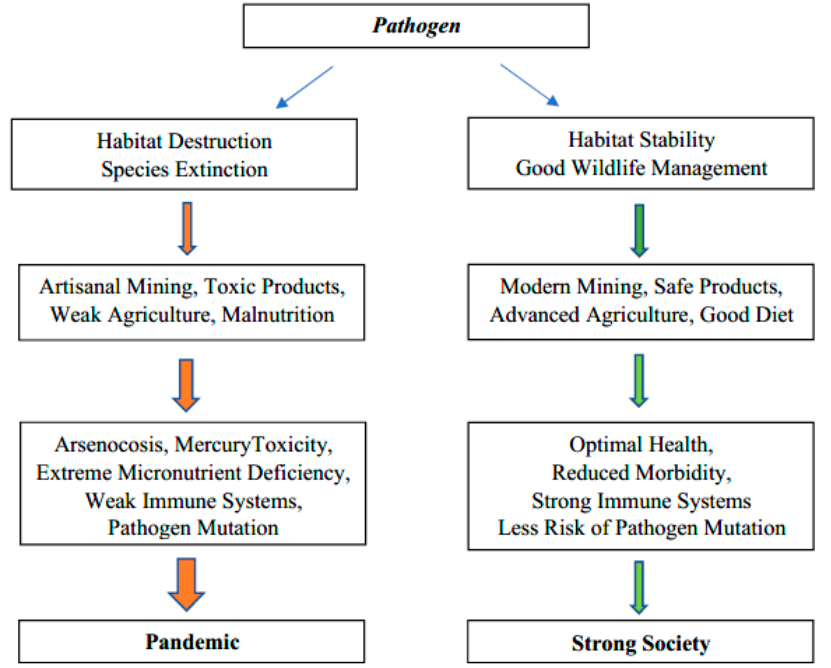
Figure 1. Graphical abstract: pathways to weak or strong ecosystem health.